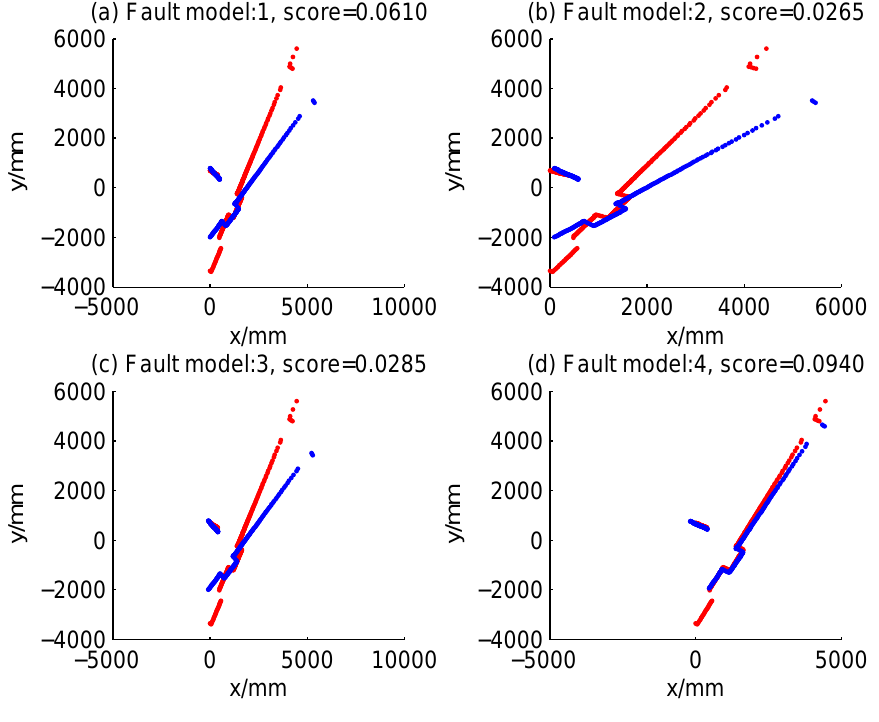
Figure 21. Case 4a:Gyroscope stuck, fault model = 4 (time Step